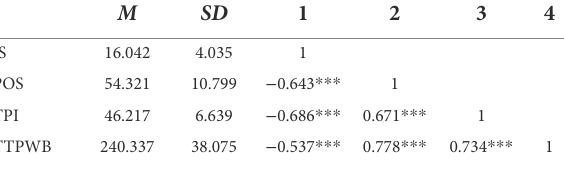
TABLE 1 Means, standard deviations, and correlations among